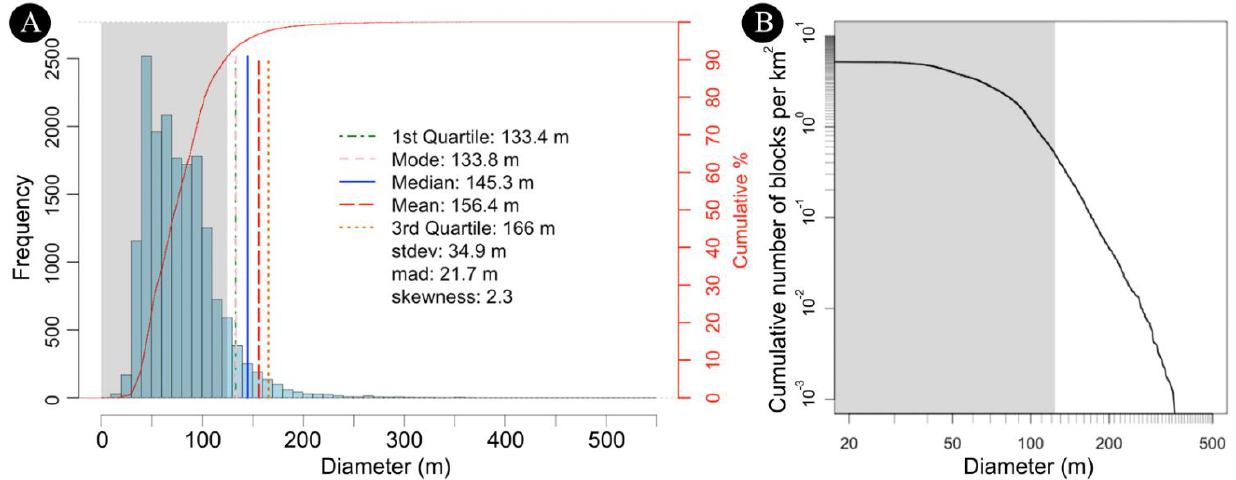
Figure 5. ( A ) Frequency histogram of all blocks identified in the yellow area of Figure 4. The grey shadowed area shows the blocks that have been identified, but their diameter is smaller than 4 pixels. The main statistical properties of the right-skewed distribution are computed only for values ≥ 125 m. ( B ) Log-log plot showing the cumulative unbinned number of blocks per km 2 . As for A, the grey shadowed area shows all blocks <125 m.